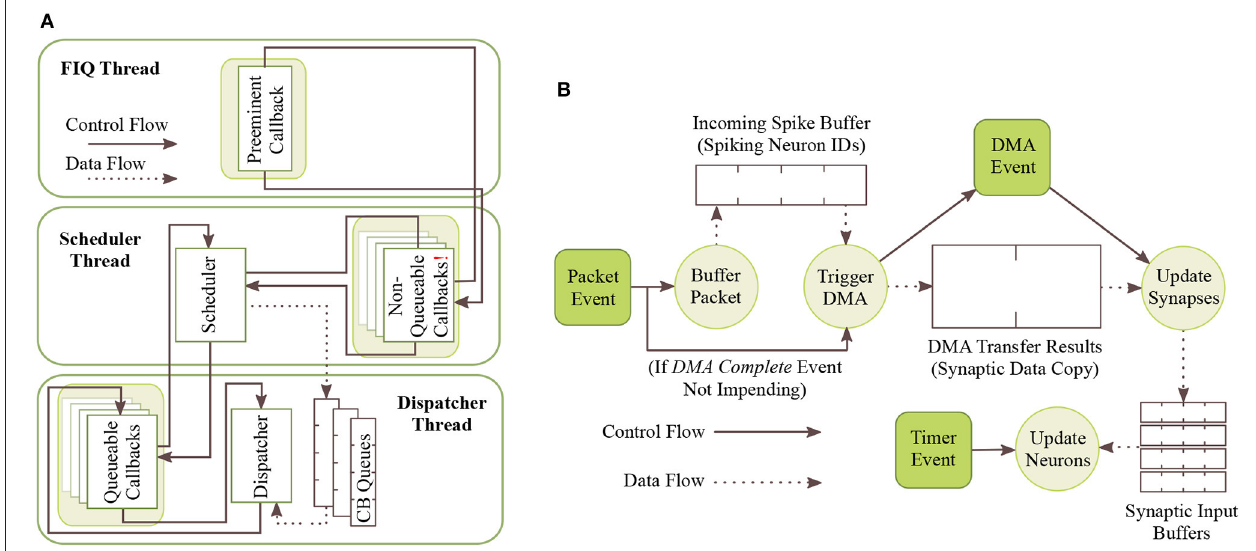
FIGURE 4 | SpiNNaker realtime OS. (A) SpiN1API multi-threaded event-based operating system: scheduler thread to queue callbacks; dispatcher thread to execute callbacks; and FIQ thread to service interrupts from high-priority (-1) events. (B) Events and associated callbacks for updating neuron state variables, and processing incoming packets representing spikes into synaptic input. Figures reproduced with permission from Sharp et al. (2011, 2012).